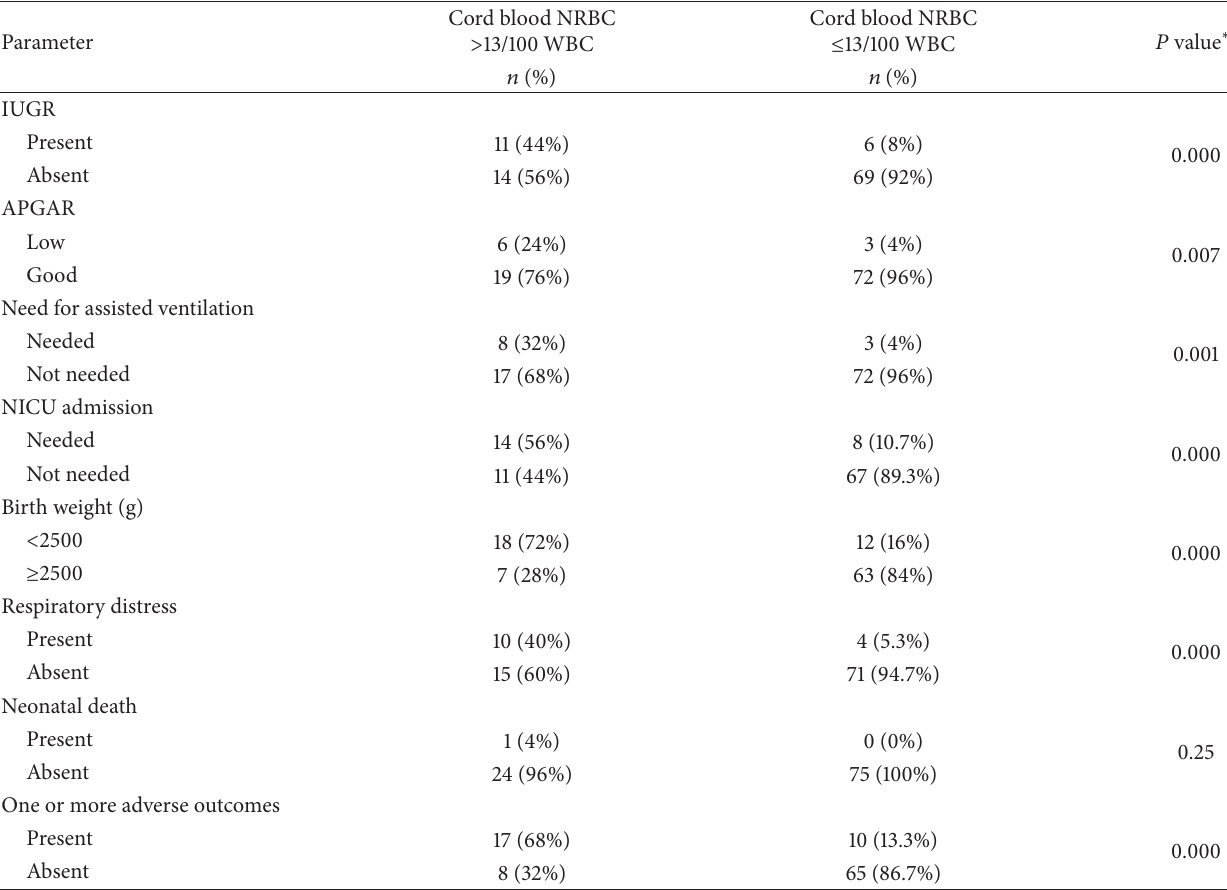
Table 4: Distribution of different neonatal outcomes (in all patients studied, 𝑛 = 100 ) with cord blood NRBC/100 WBC cutoff of 13 ( > 13 and ≤ 13, resp., in each neonatal